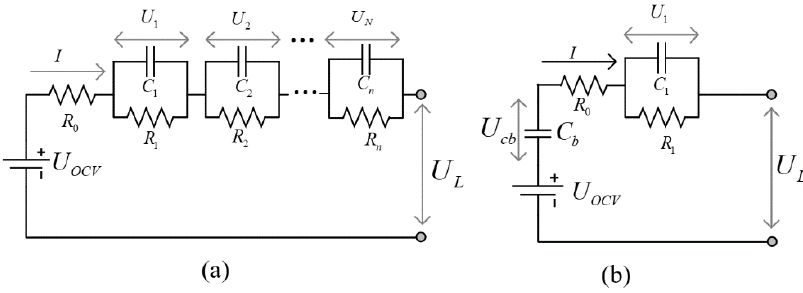
Figure 2. Schematics of equivalent circuit models (ECMs): ( a ) Resistance-capacitance (nRC) model and ( b ) the Partnership for a New Generation of Vehicle (PNGV) model.